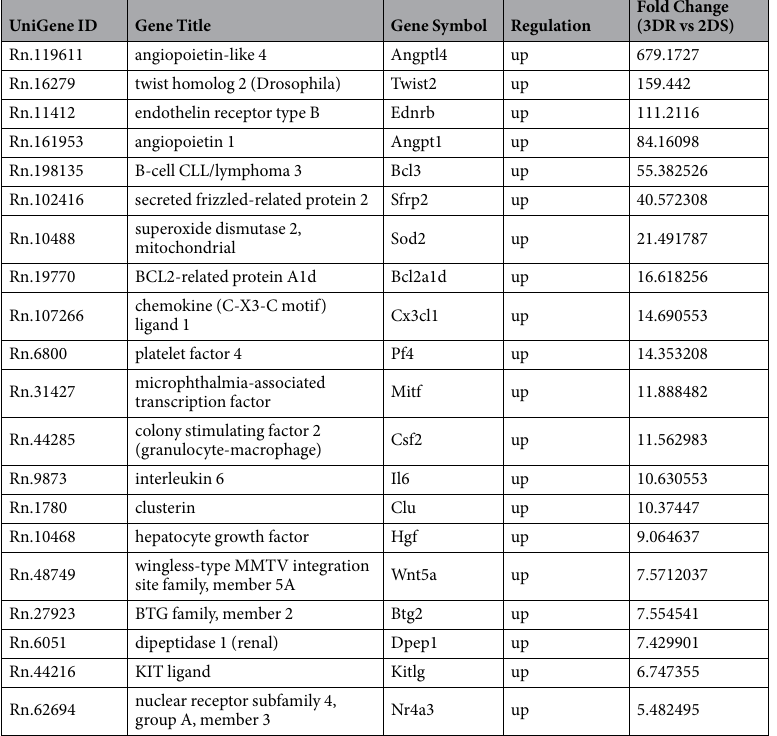
Table 2. Top 20 up-regulation gene expression of negative regulation of apoptotic process in biological process analysis.